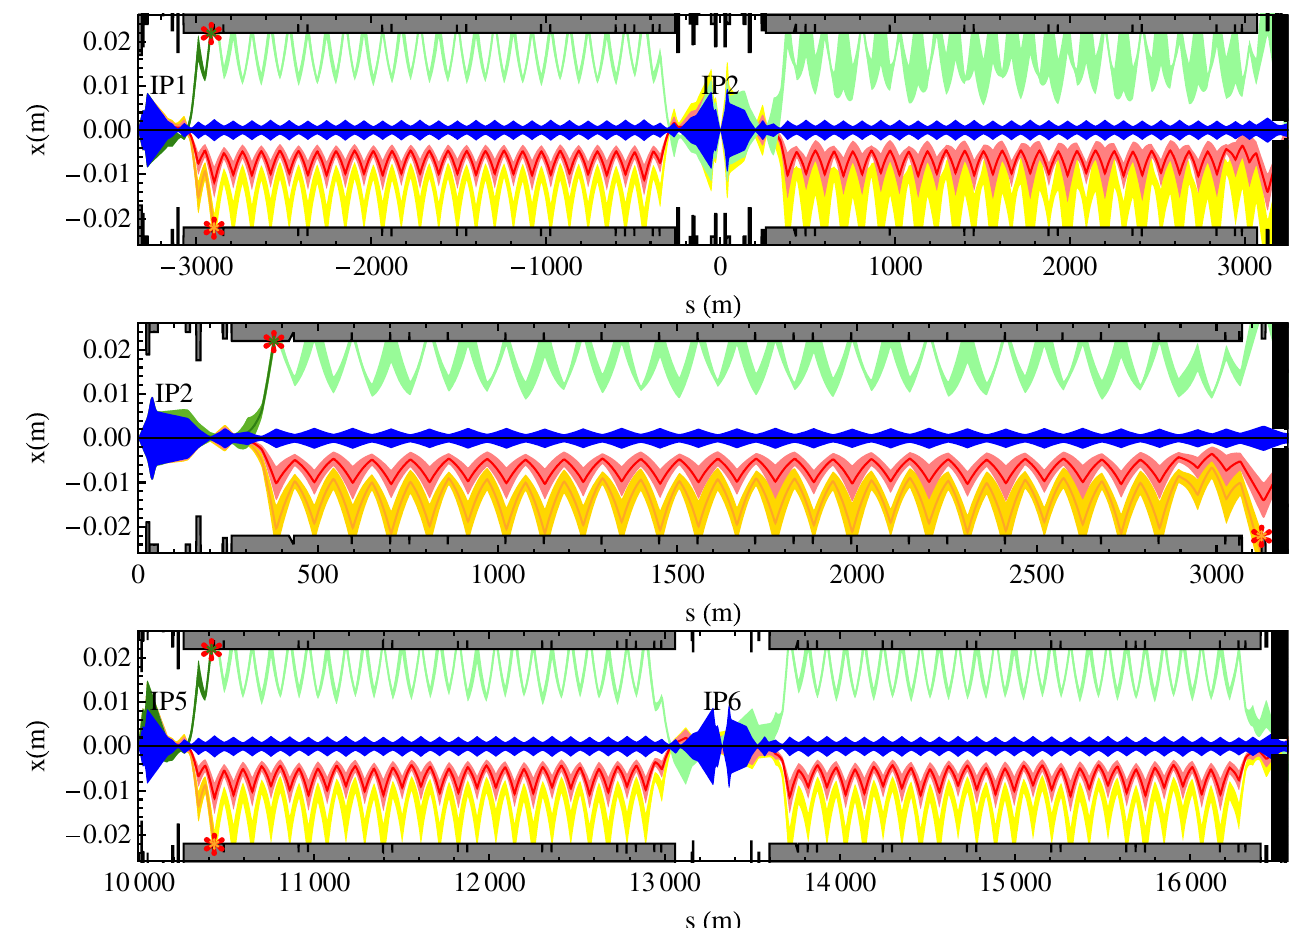
FIG. 2. (Color) The simulated horizontal 6 (cid:1) envelopes of the nominal 208 Pb 82 þ beam (blue), the 208 Pb 81 þ BFPP beam (green), the 207 Pb 82 þ EMD1 beam (red), and the 206 Pb 82 þ EMD2 beam (yellow) coming out of IP1 (top), IP2 (middle), and IP5 (bottom) in the LHC, with the machine aperture superimposed. The envelopes are plotted in a lighter color after the impact (indicated by a red star) of the central orbit on the aperture. The horizontal scales have s ¼ 0 at each IP in turn and the closest horizontal collimators are represented as black boxes at 6 (cid:1) to the right. The length of the collimators is not to scale for the sake of